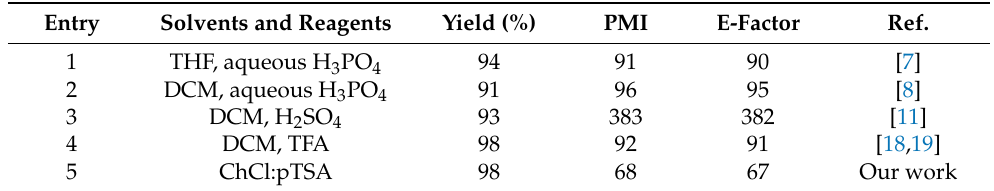
Table 4. Calculated green metrics percentage yield, PMI, and E-factor for our Boc deprotection procedure and for already reported methods.